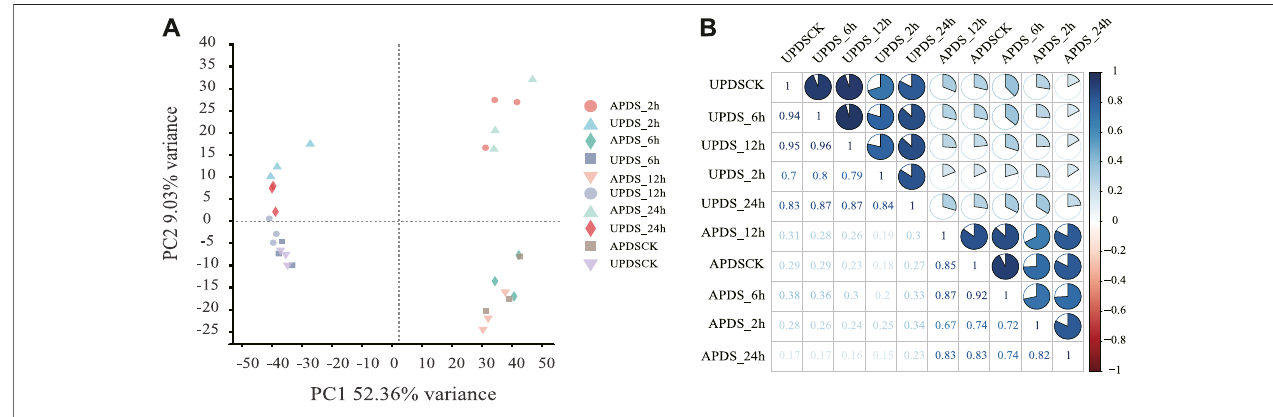
FIGURE 1 | Evaluation of RNA sequence sample dataset used to identify alternative splicing (AS) events. (A) Principal component analysis of RNA sequence sample data. Samples from aboveground and underground parts formed different clusters at different time points (APDS_2h, APDS_6h, APDS_12h, APDS_24h, UPDS_2h, UPDS_6h, UPDS_12h and UPDS_24h). (B) Correlation analysis between samples. Correlation matrices were calculated by comparing the mean values of entire transcriptome in samples from aboveground and underground parts at different time points during drought treatment. Pearson ’ s correlation coef fi cients between samples were analyzed using an R script.